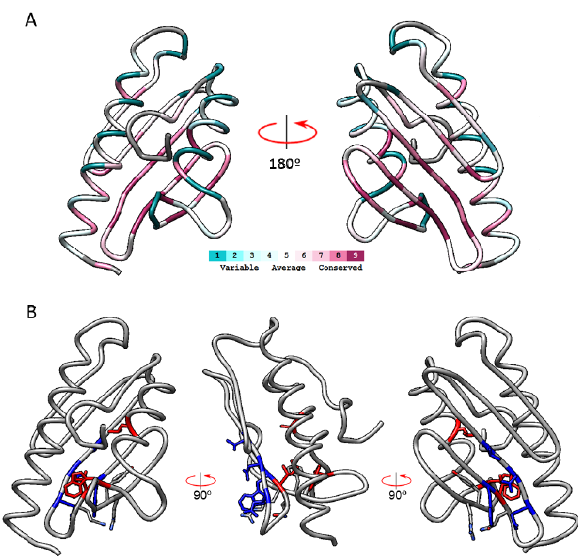
Figure 3. Frataxin structure (PDB ID:3S4M) indicating the conserved amino acids identified in ConSurf-ID20 analysis. In ( A ), frataxin structure is shown in ribbons and colored according to the conservation scores calculated by ConSurf. In ( B ), highly conserved amino acids (ConSurf score = 9) are shown in sticks and colored according to the conservation clusters defined: cluster 1 red, cluster 2 blue. Amino acids from cluster 3 and cluster 4 are not shown, as they are not highly conserved in this second analysis (which includes many bacterial CyaY proteins). Q153, R165, and Y166, which presented an s = 9 in this second analysis but not in the first one, are colored by element (CPK col- oring).